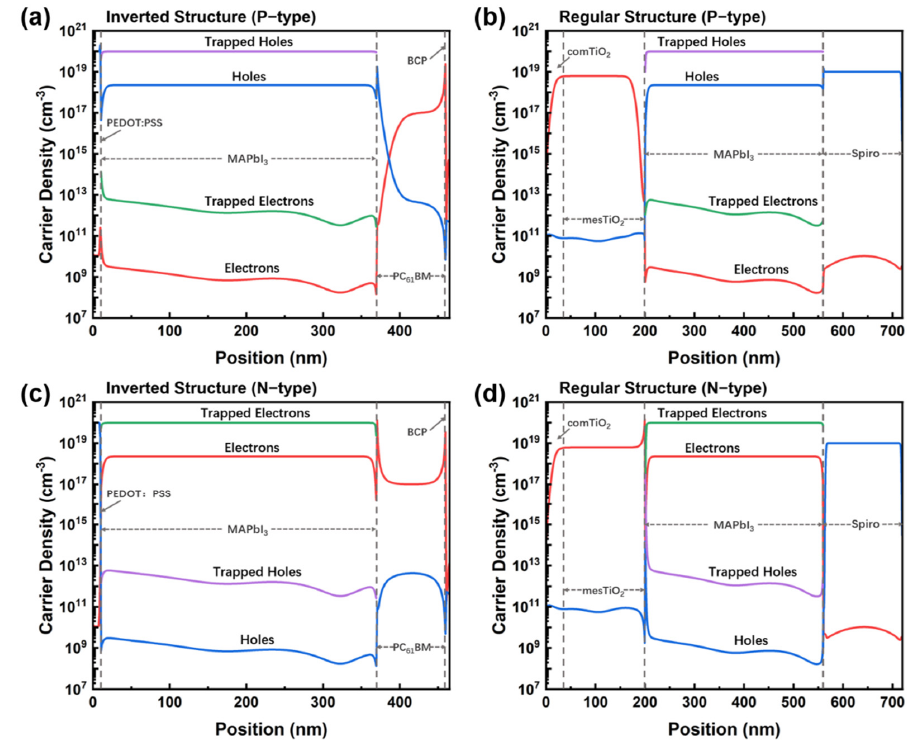
Figure 3. Carrier distribution under ( a , b ) P-doped and ( c , d ) N-doped perovskite conditions where ( a , c ) are for the inverted-structure photodiode and ( b , d ) for the regular-structure photodiode. The position refers to the cross-sections of the inverted structure and the regular structure, respectively. The dashed grey lines are used to identify each layer in the perovskite photodiodes.